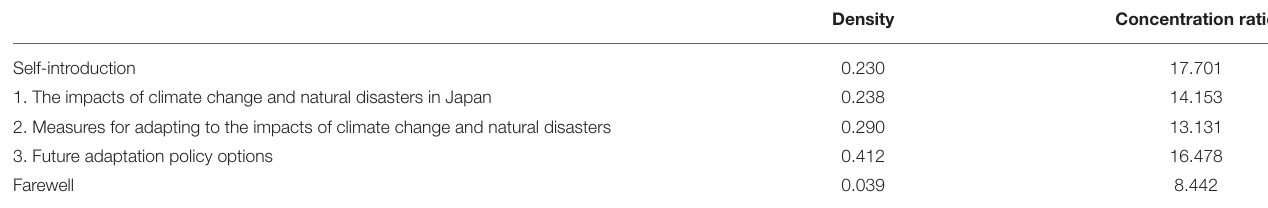
TABLE 2 | Density and concentration ratio of the network graph in each topic.